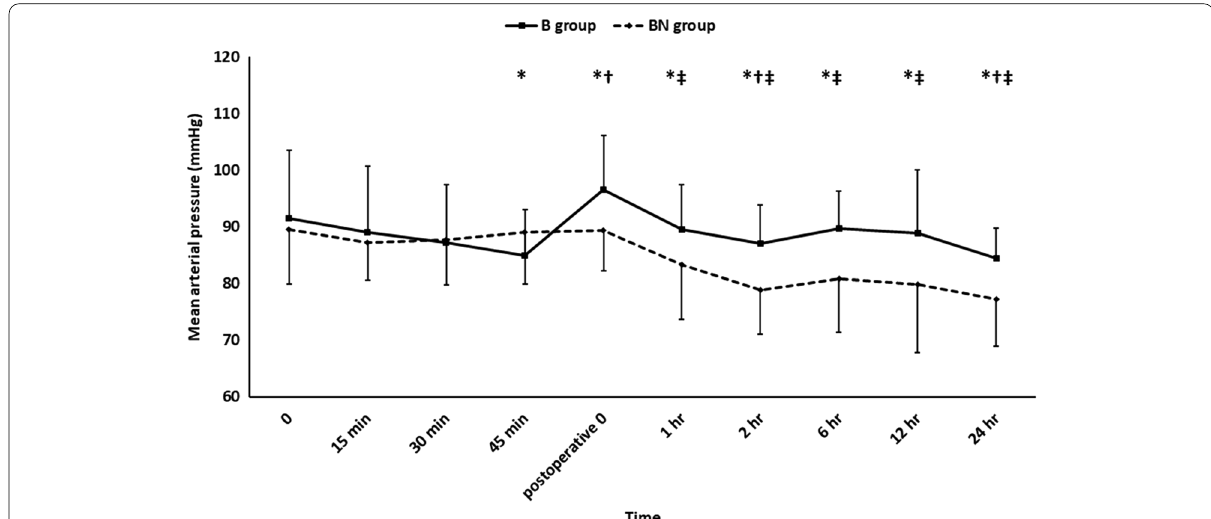
Fig. 3 Mean arterial pressure. Markers are means, and error bars are standard deviations. * denotes significance between the 2 groups, † denotes significance in relation to the baseline reading in the B group, and‡ denotes significance in relation to the baseline reading in the BN